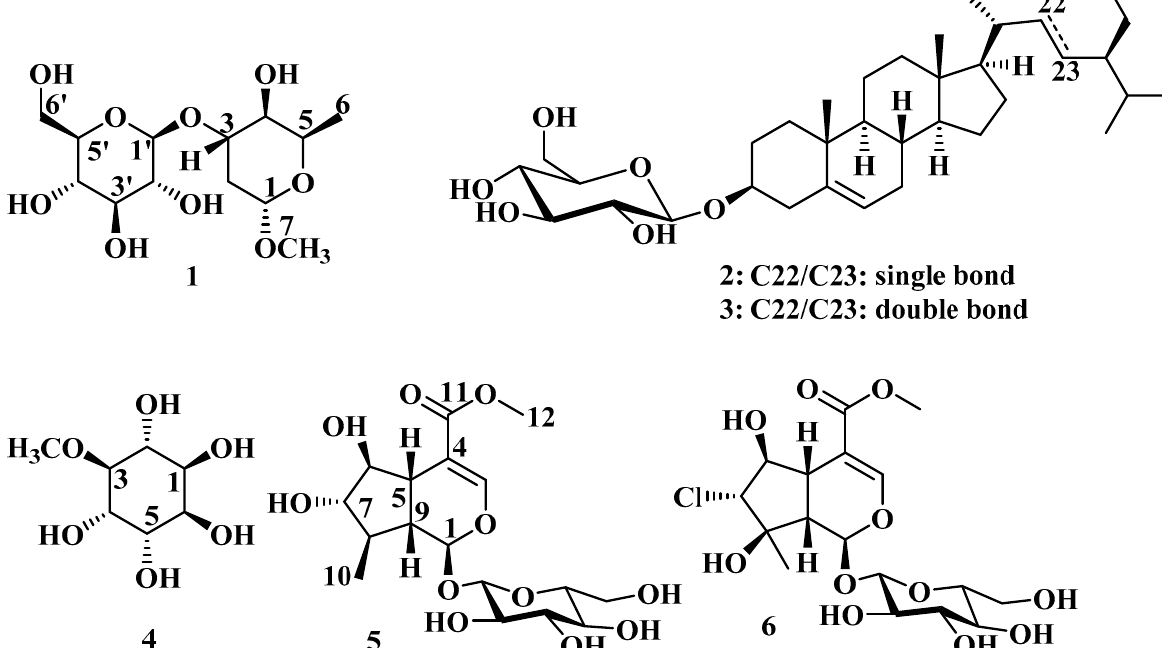
Figure 1. Chemical structures of the isolated compounds from the aerial parts of L. setulosus.